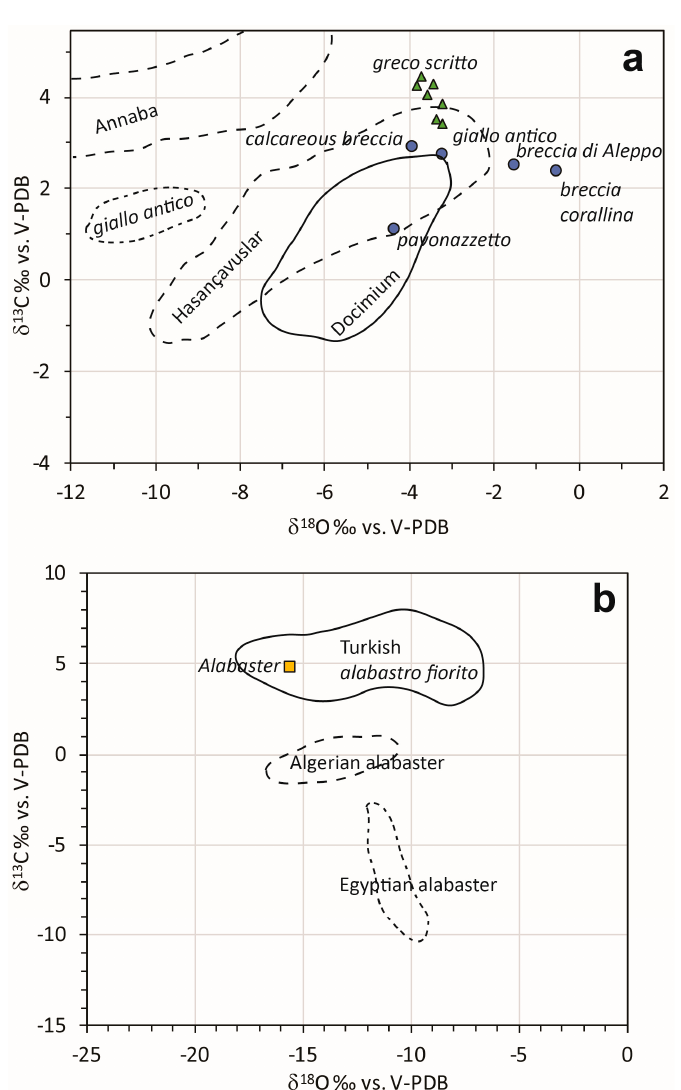
Figure A1. Stable isotope scatterplot of the colored stones from Aléria: ( a ) approximate isotopic fields of greco scritto (Annaba, Algeria [45], Hasançavuslar, Ephesus, Turkey [44]) giallo antico [4], Docimium [2] are shown; ( b ) isotopic fields of different calcitic alabasters exploited in antiquity [43].